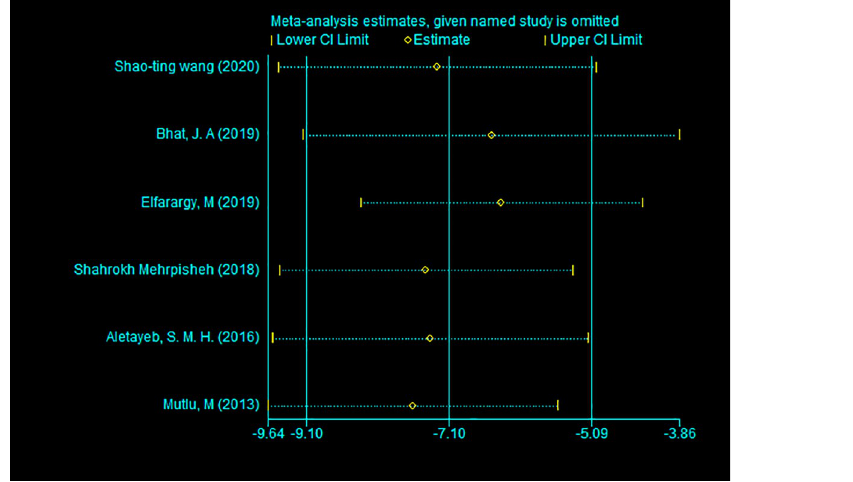
Fig 3. Sensitivity analysis of included